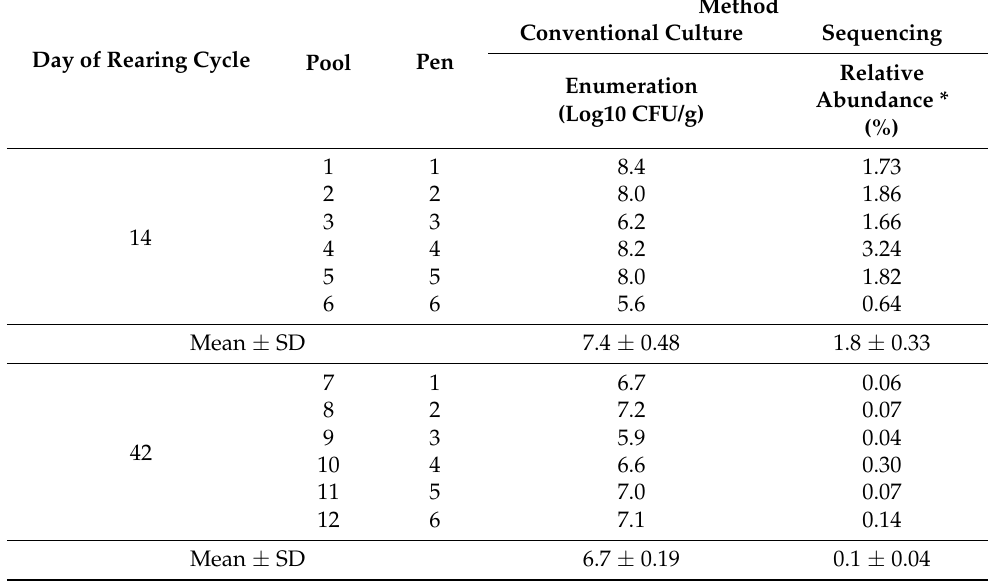
Day of Rearing Cycle Pool Pen